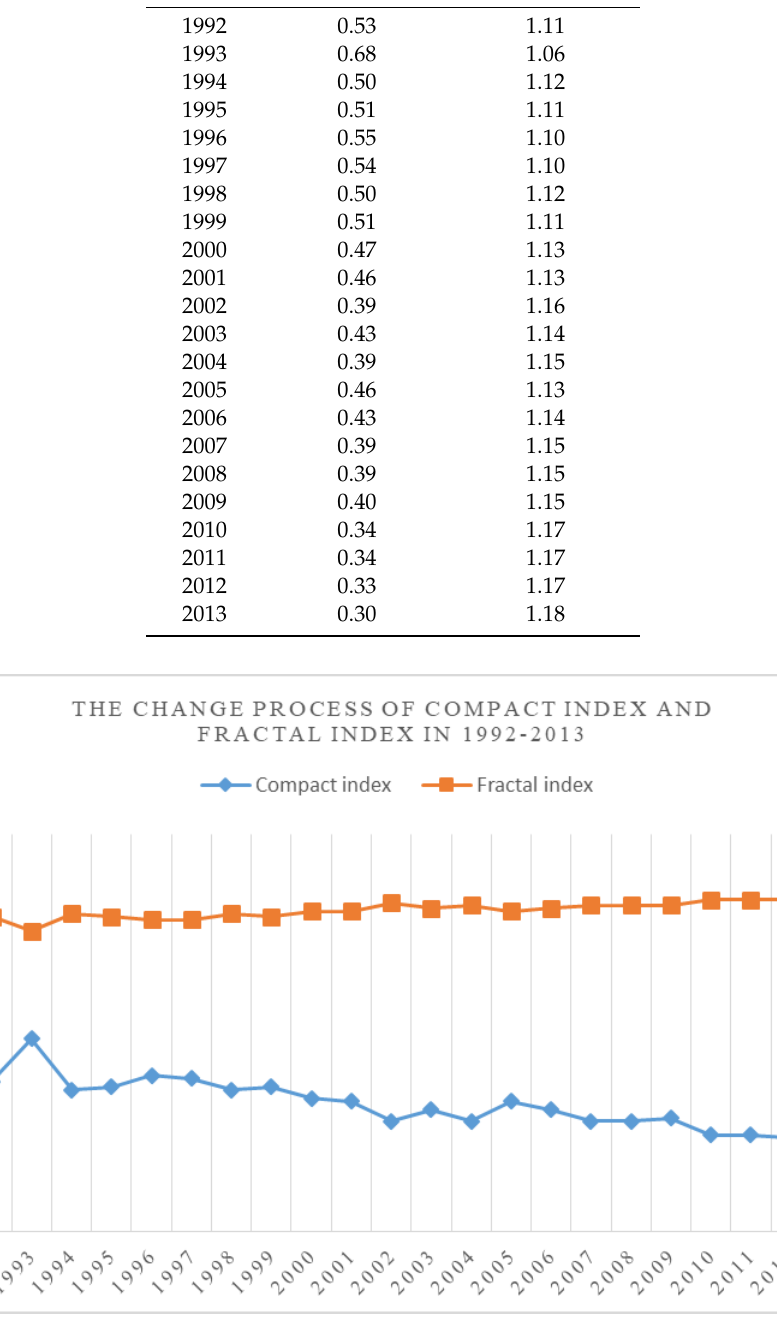
Figure 4. Diagram of the process of change in the Compact Index and Fractal index of the YREB in 1992–2013.